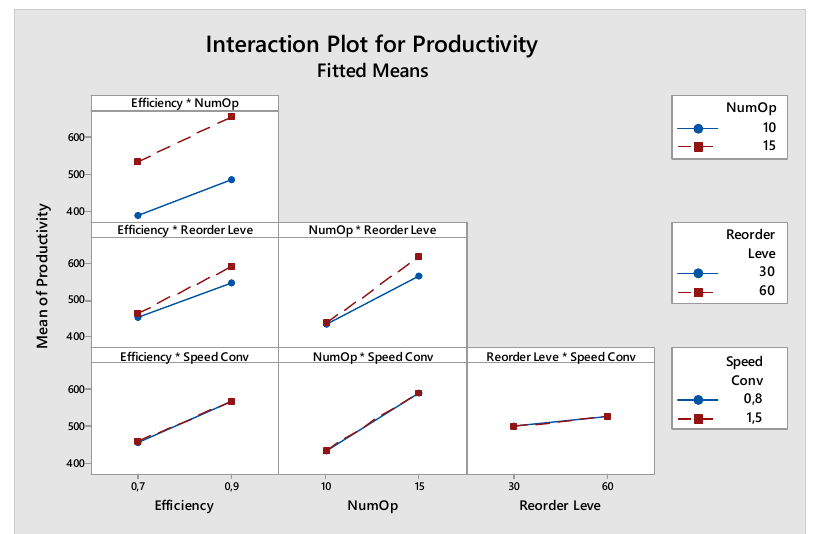
Figure 12. Interaction Plot for Productivity.